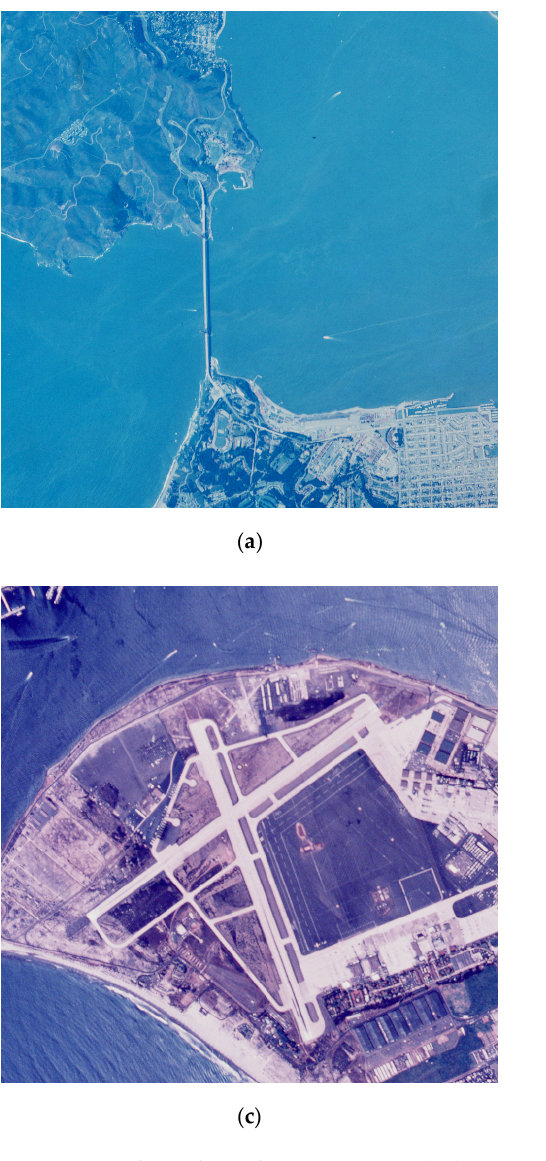
Figure 9. Three-channel remote sensing (RS) test images: ( a ) Frisco; ( b ) Diego2; ( c ) Diego3; ( d ) Diego4.